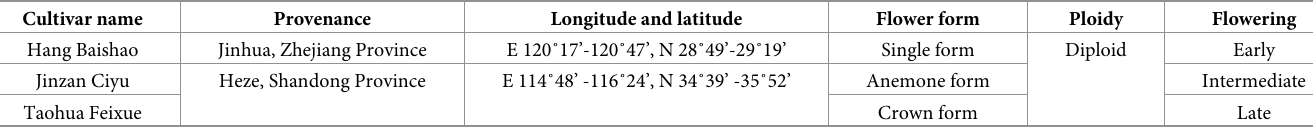
Table 1. Main information of three representative cultivars with typical early, intermediate and late sprouting and flowering. Cultivar name